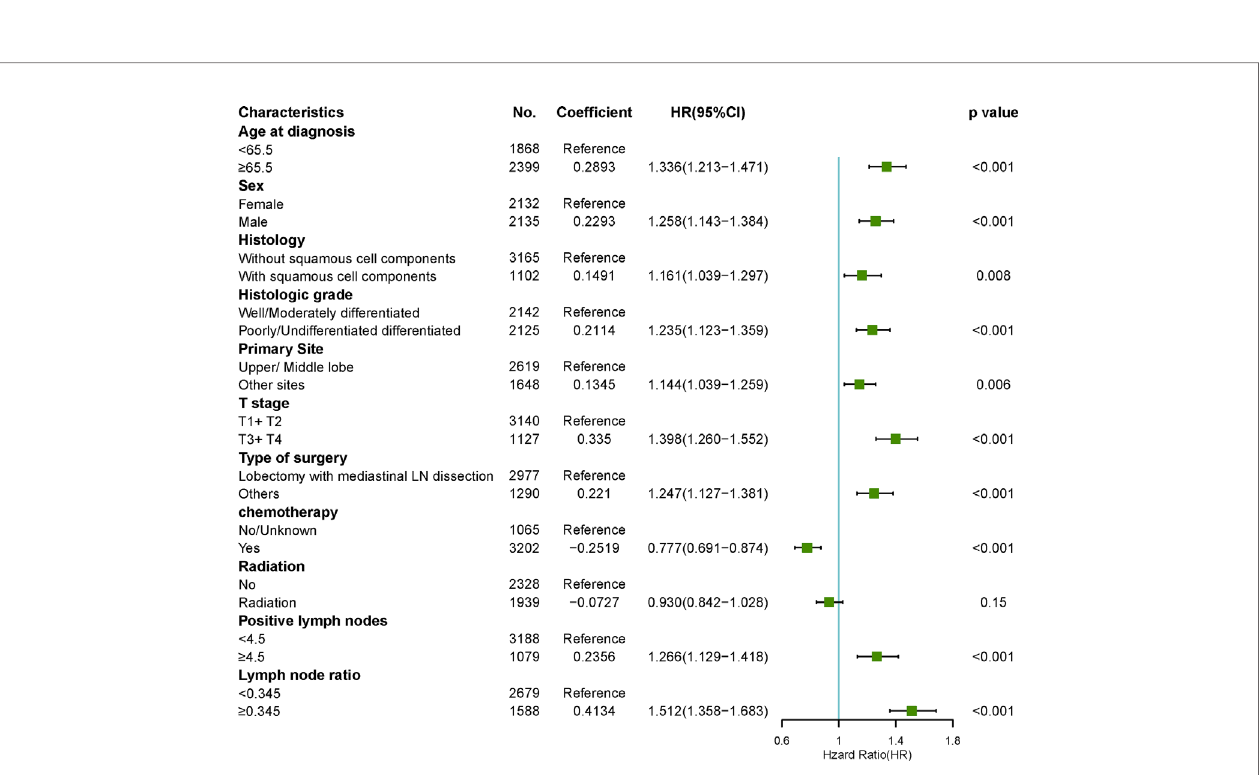
FIGURE 6 | Forest plots visualizing the hazard ratios of clinicopathological characteristics for lung cancer-speci fi c mortality in patients with pN2 who underwent surgery using a multivariate competing risk